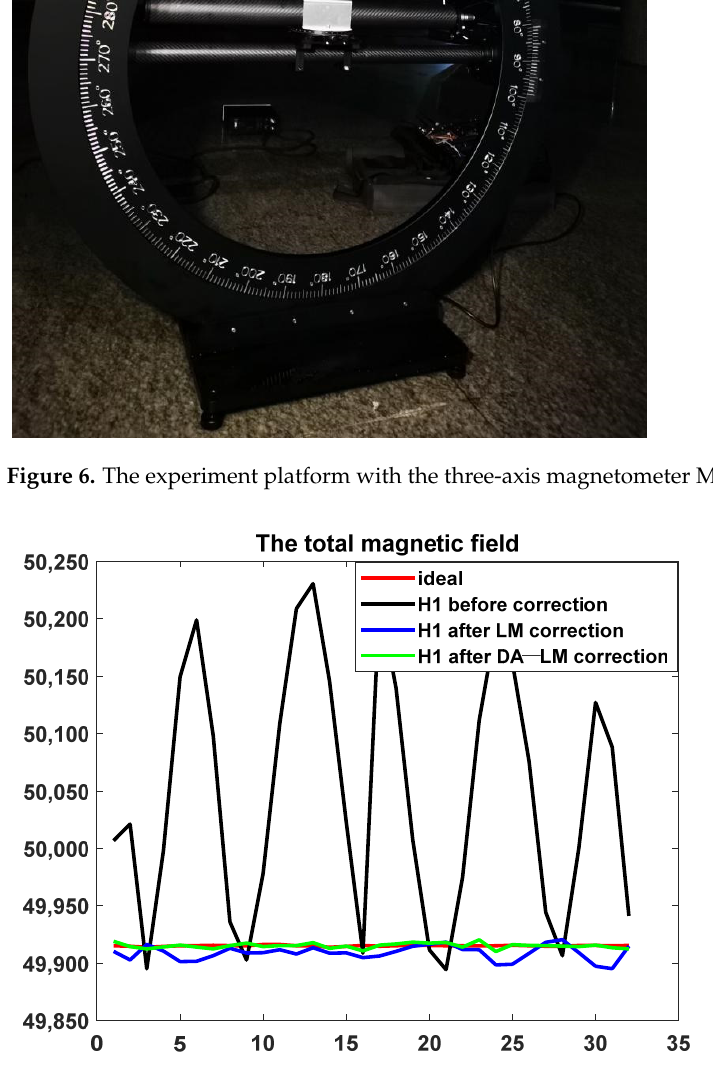
Figure 7. The total magnetic field before and after correction.